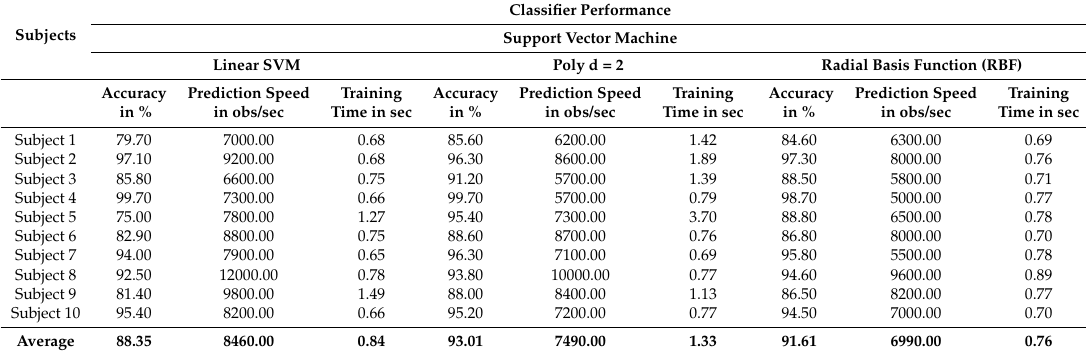
Table 6. Identification results of linear and kernel-based (polynomial d = 2 and radial basis function) support vector machine (SVM) including accuracy, prediction speed, and training time with the reduced 7D Feature Space.